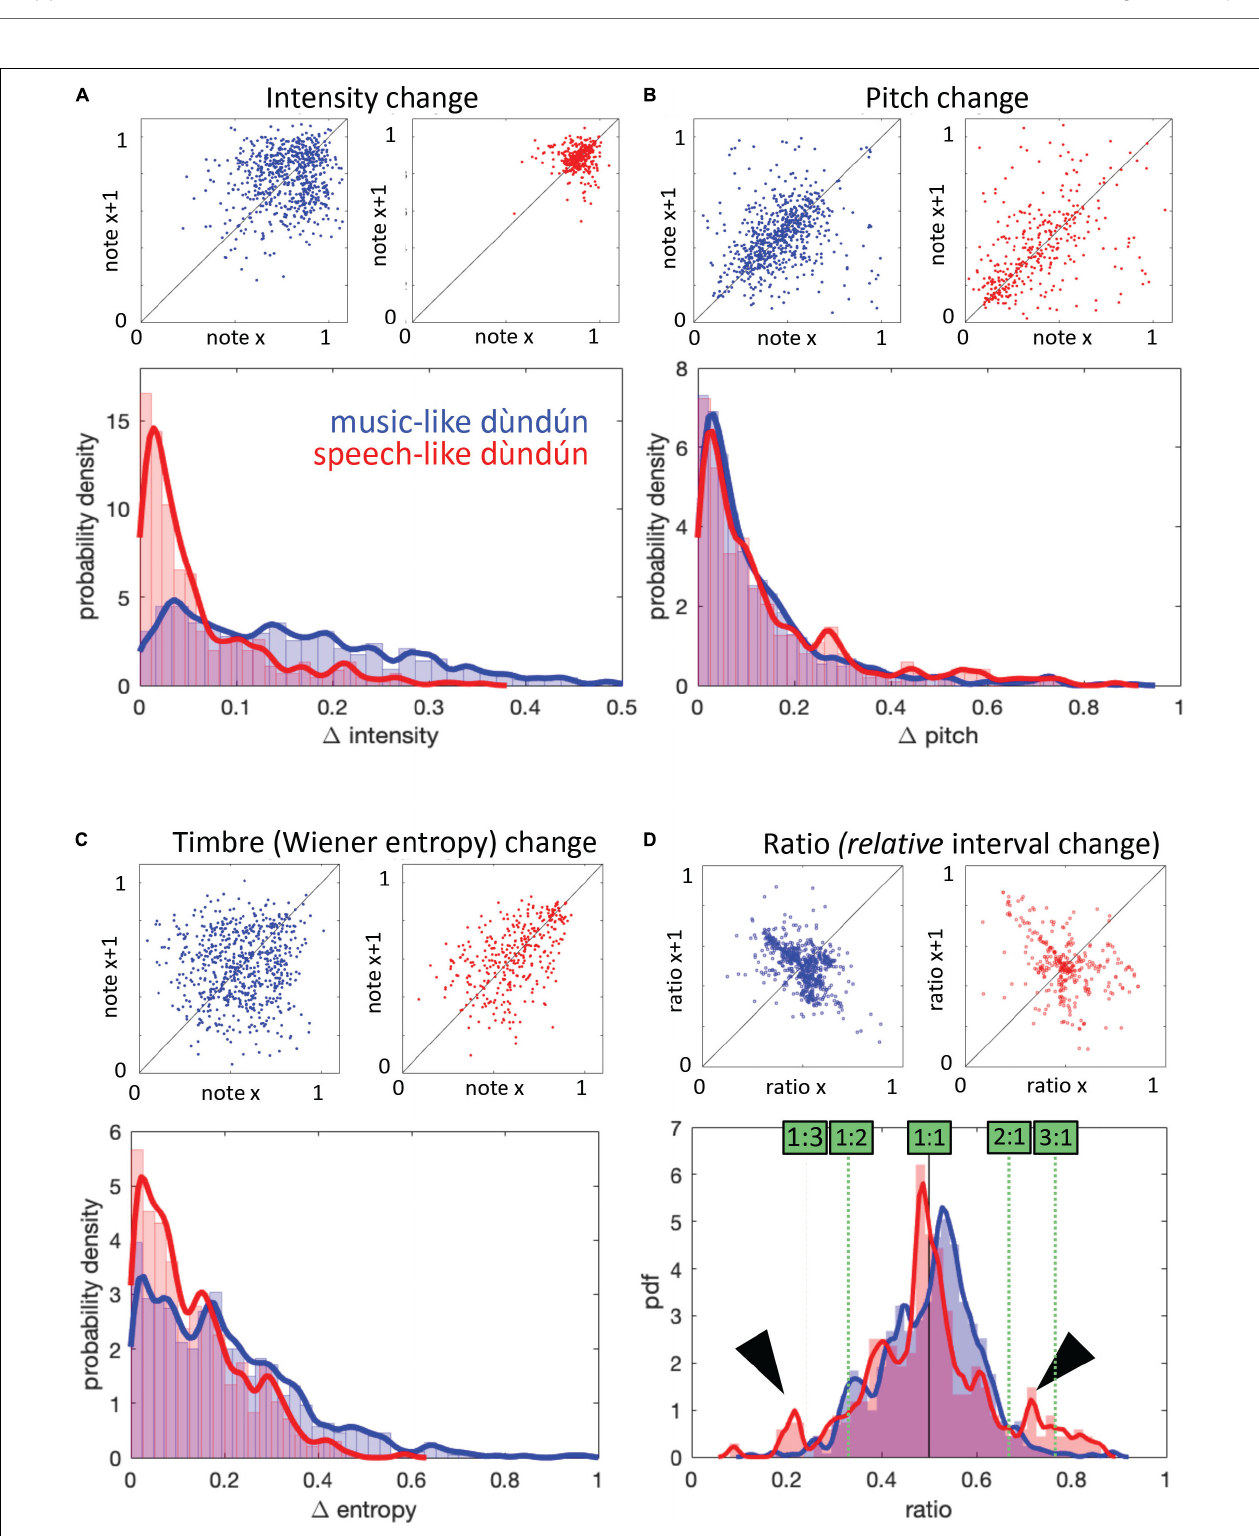
FIGURE 4 | Acoustic measures computed at the level of consecutive notes for music-like (blue) and speech-like (red) dùndún performances. All measures are scaled from 0 to 1. (A) Mean intensity change: The top panel shows, for each pair of consecutive notes, the intensity of the pair’s first note on the x -axis, and of the second note on the y -axis. The diagonal line indicates where note pairs with two similar note intensities would fall. The bottom panel shows the probability density of intensity differences. (B,C) are the Mean pitch change and Mean timbre change, illustrated following the same logic as (A) . (D) Similar illustration for change in IOIs, as measured by ratio = interval1 / (interval1+interval2). In the probability density plot (bottom), green boxes and dashed lines mark interval ratios in terms of “interval1: interval2,” an alternative way to describe interval ratios, commonly used in music